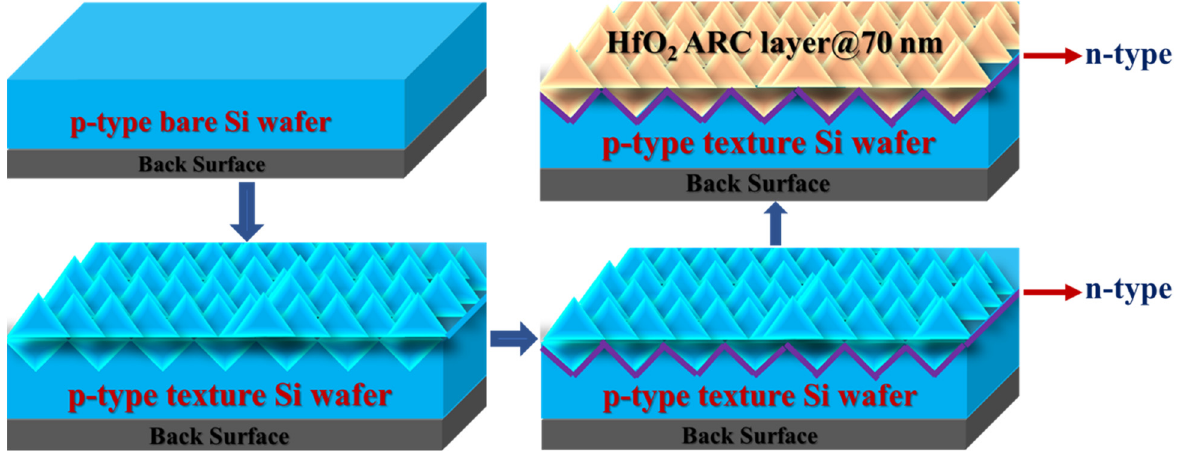
Figure 1. Illustration of the proposed framework for constructing the HfO 2 ARC layer-based c-Si solar cell.